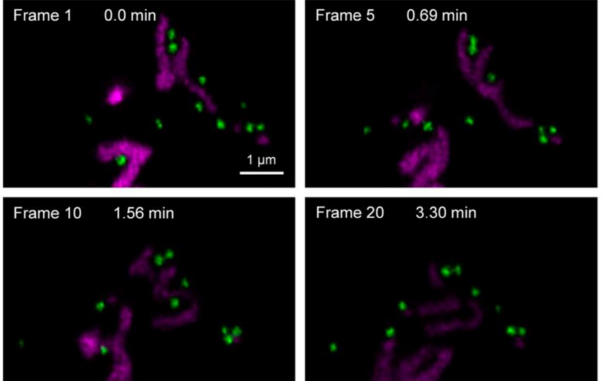
Figure 4. Two-color STED super-resolution imaging of living HeLa cells. The lipid droplets (green) and mitochondria (purple) were labeled with Lipi-DSB and TMRM, respectively (scale bar = 1 µ m); the STED images were recorded under two excitation lasers (470 nm for Lipi-DSB, 550 nm for TMRM) and one STED laser (660 nm CW-STED, 40 MW cm − 2 ). Reprinted (adapted) with permission from Zhou, R.; Wang, C.; Liang, X.; Liu, F.; Yan, X.; Liu, X.; Sun, P.; Zhang, H.; Wang, Y.; Lu, G.